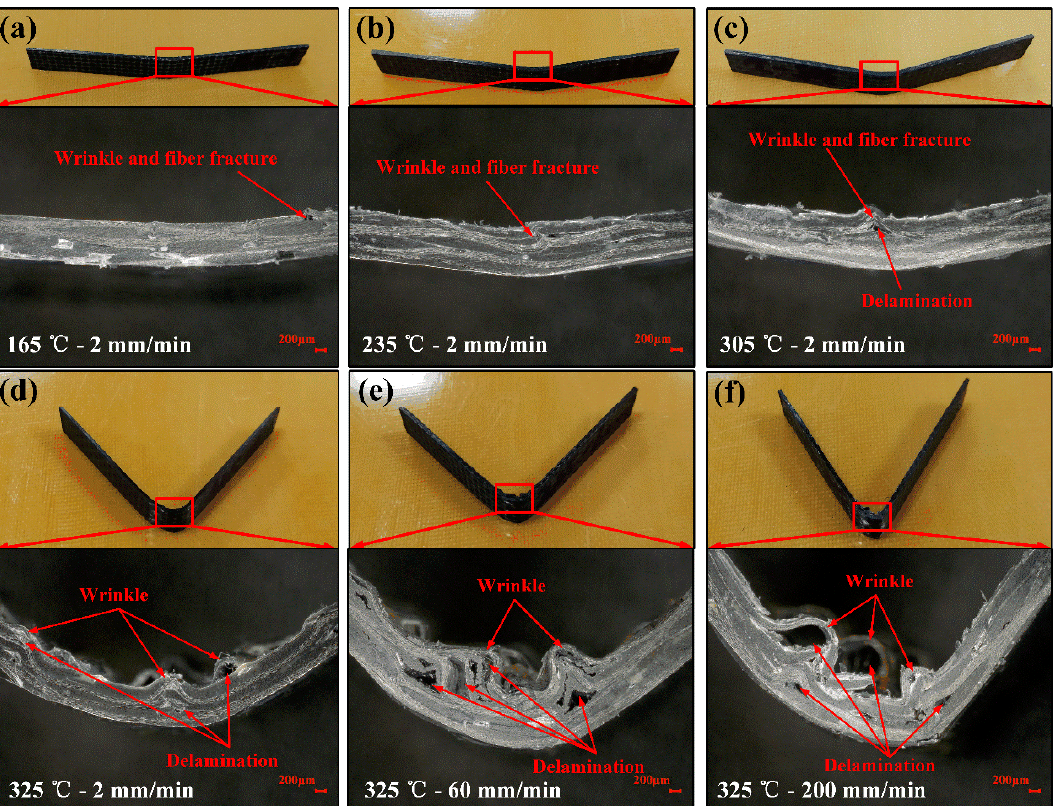
Figure 8. Micrographs of the fracture surfaces of woven CF / PEEK composites after flexural testing under di ff erent conditions: ( a ) 165 ◦ C—2 mm / min, ( b ) 235 ◦ C—2 mm / min, ( c ) 305 ◦ C—2 mm / min, ( d ) 325 ◦ C—2 mm / min, ( e ) 325 ◦ C—60 mm / min, and ( f ) 325 ◦ C—200 mm / min.